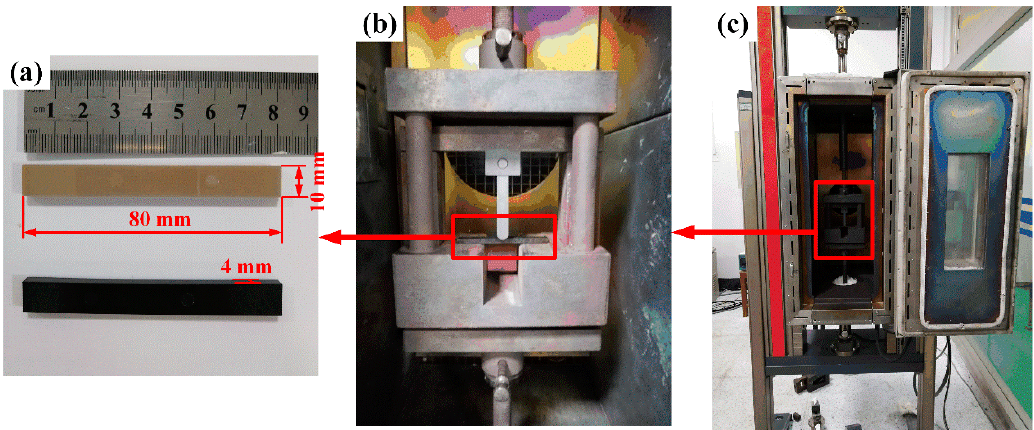
Figure 1. Representation of thermomechanical quasi-static flexural test: ( a ) Flexural specimens; ( b ) Flexural mold; ( c ) Test equipment.